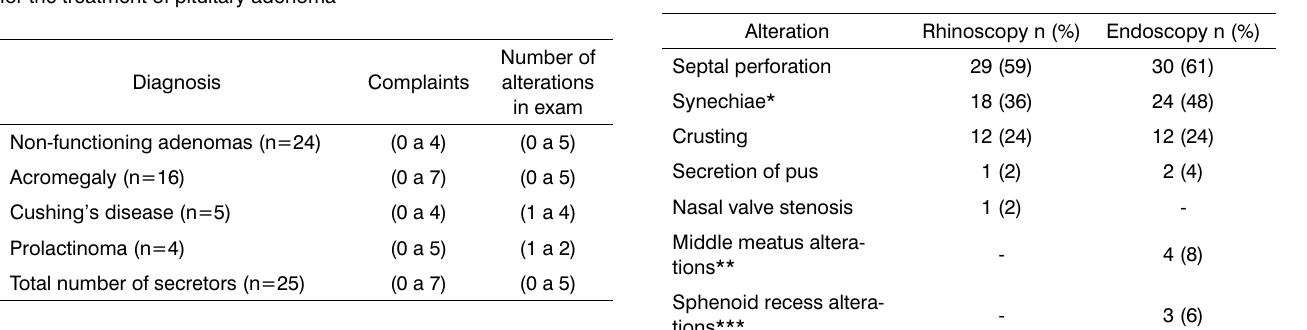
Table 3. Anterior rhinoscopic and nasal endoscopic findings in pa- tients undergoing transsphenoidal